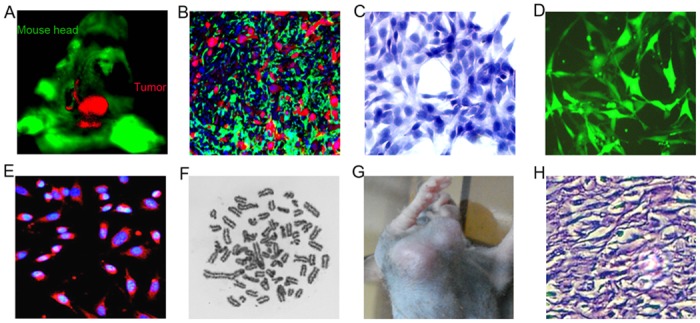
Origin of ihBTCs.A, Under the in vivo fluorescence imaging system, SU3-RFP xenotransplanted tumors in the right caudate nucleus of EGFP nude mice were red. B, Red tumor cells interweave with the green host cells in the xenotransplanted tumor frozen section observed under a fluorescent microscope (scale plate 20 μm). C, HE staining of ihBTC cells. D-E, (scale plate of 50 μm) IhBTC cells express EGFP in in vitro culture. Immunofluorescence reveals that ihBTC2 cells highly express the oligodendrocyte marker CNP (in red and DAPI in blue). F, Karyotype analysis indicates that ihBTC2 cells are hyperpentaploid and all chromosomes are monocentric. G and H, Large tumor formed in non-fluorescent nude mice after subcutaneous injection of ihBTC2 cells. H&E staining of the tumors showed the malignant tumor features of poor differentiation, pleomorphism, hyperchromatic nuclei, loss of polarity and local invasion (200×).